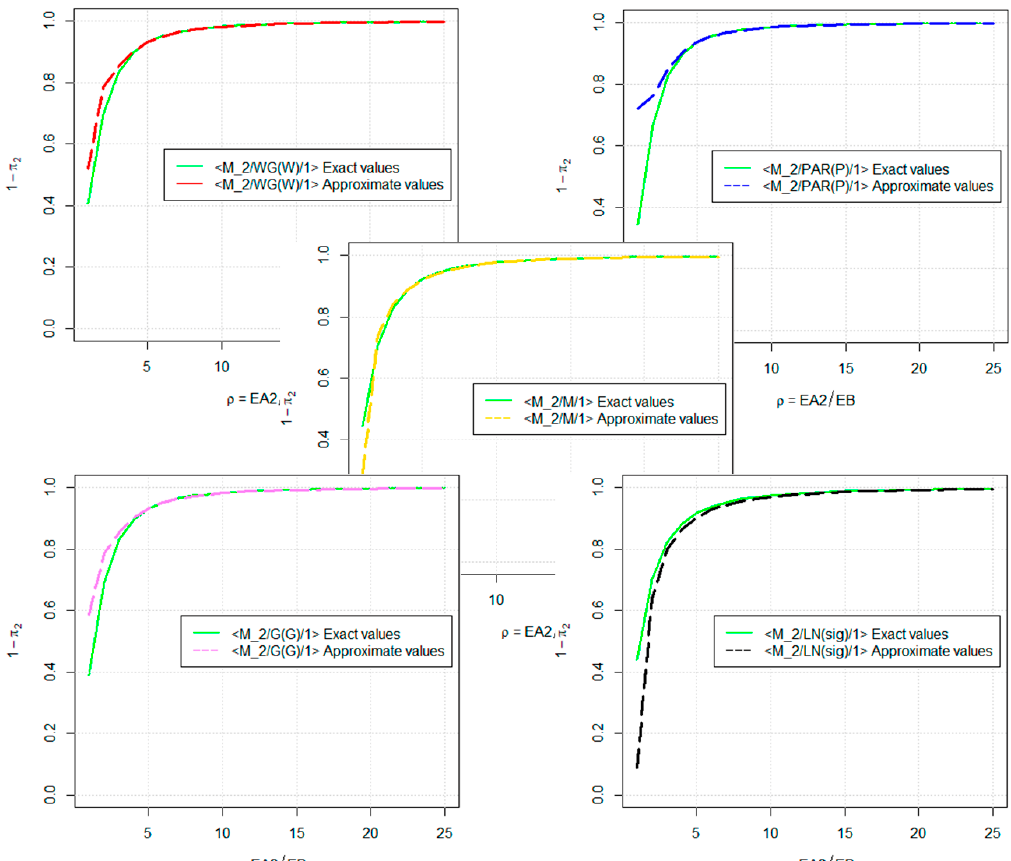
Figure 5. Graphs of the probability of failure-free system operation 1 − p 2 versus ρ , constructed by exact and asymptotic formulas.